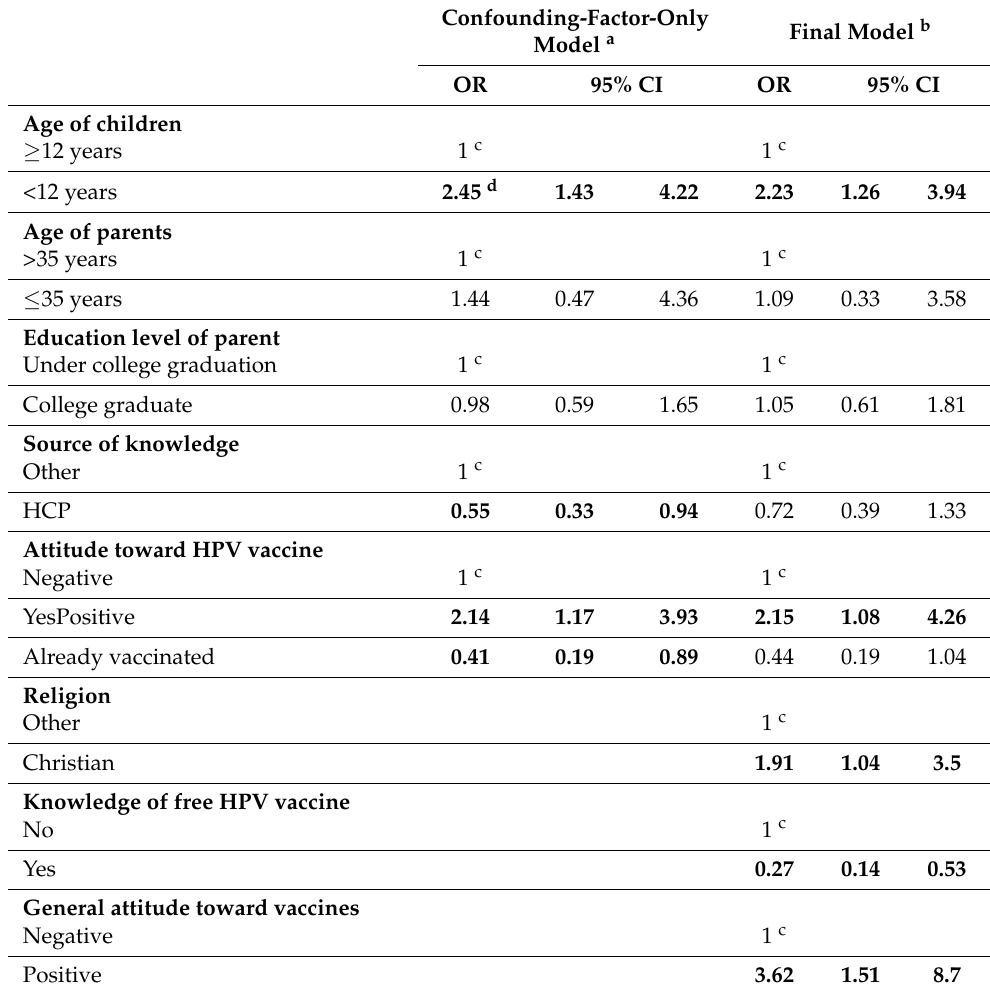
Table 5. Odds ratios (ORs) for perceived need of more information on the HPV vaccine and corre- sponding 95% confidence intervals (CIs) for selected confounding and risk